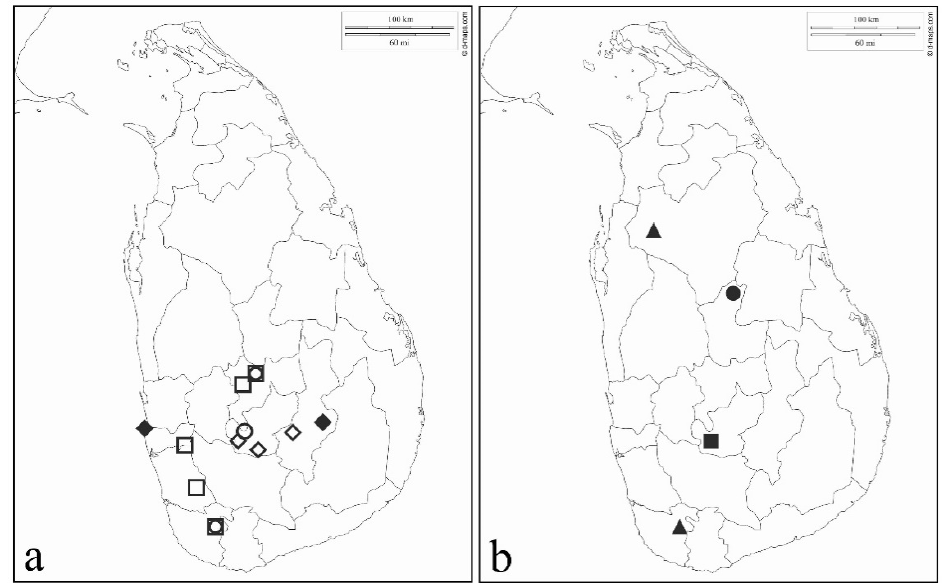
Figure 18. Distributional maps of Taumacera from Sri Lanka: ( a ) □ — T. cervicornis (Baly, 1861), ○ — T. lewisi (Jacoby, 1887), ◊ — T. mirabilis (Jacoby, 1887), ♦ — T. unicolor (Jacoby, 1887); ( b ) ▲ — T. adamskii sp. nov., ■ — T. maskeliya sp. nov., ● — T. sigiriya sp. nov.